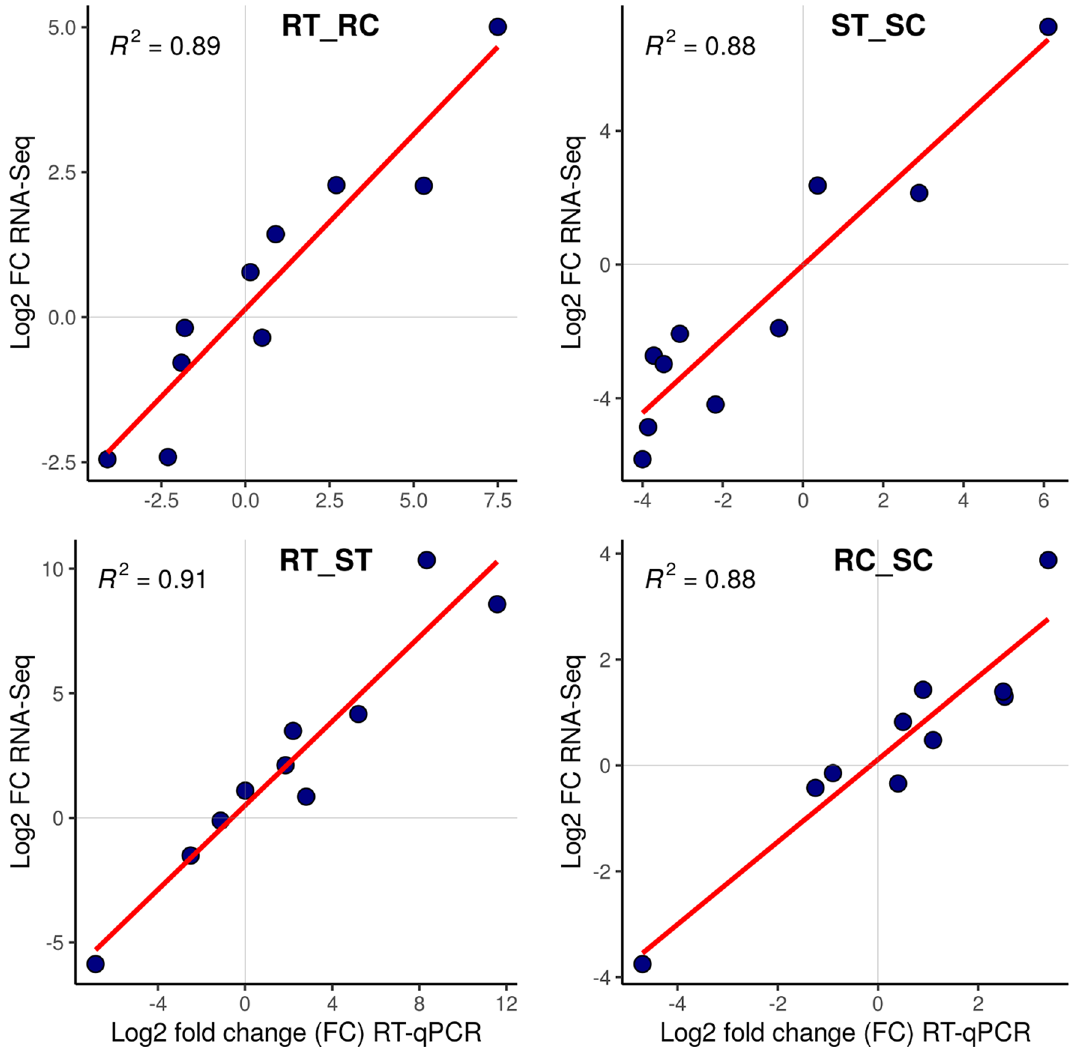
Figure 3. Regression analysis of the log 2 (fold-change) values between RNA-seq and RT-qPCR in all four comparisons. RC (resistant control), RT (resistant treatment), SC (susceptible control), and ST (susceptible treatment). The plots were created using ‘ggplot2 version 3.3.5’ R/CRAN package (https:// ggplo t2. tidyv erse.